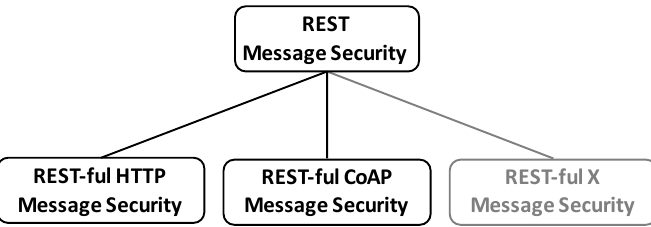
Figure 8. General REST message security and its instantiation to concrete REST-ful